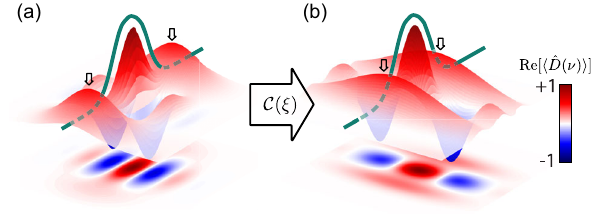
FIG. 1. Protection of quantum interference against photon loss.